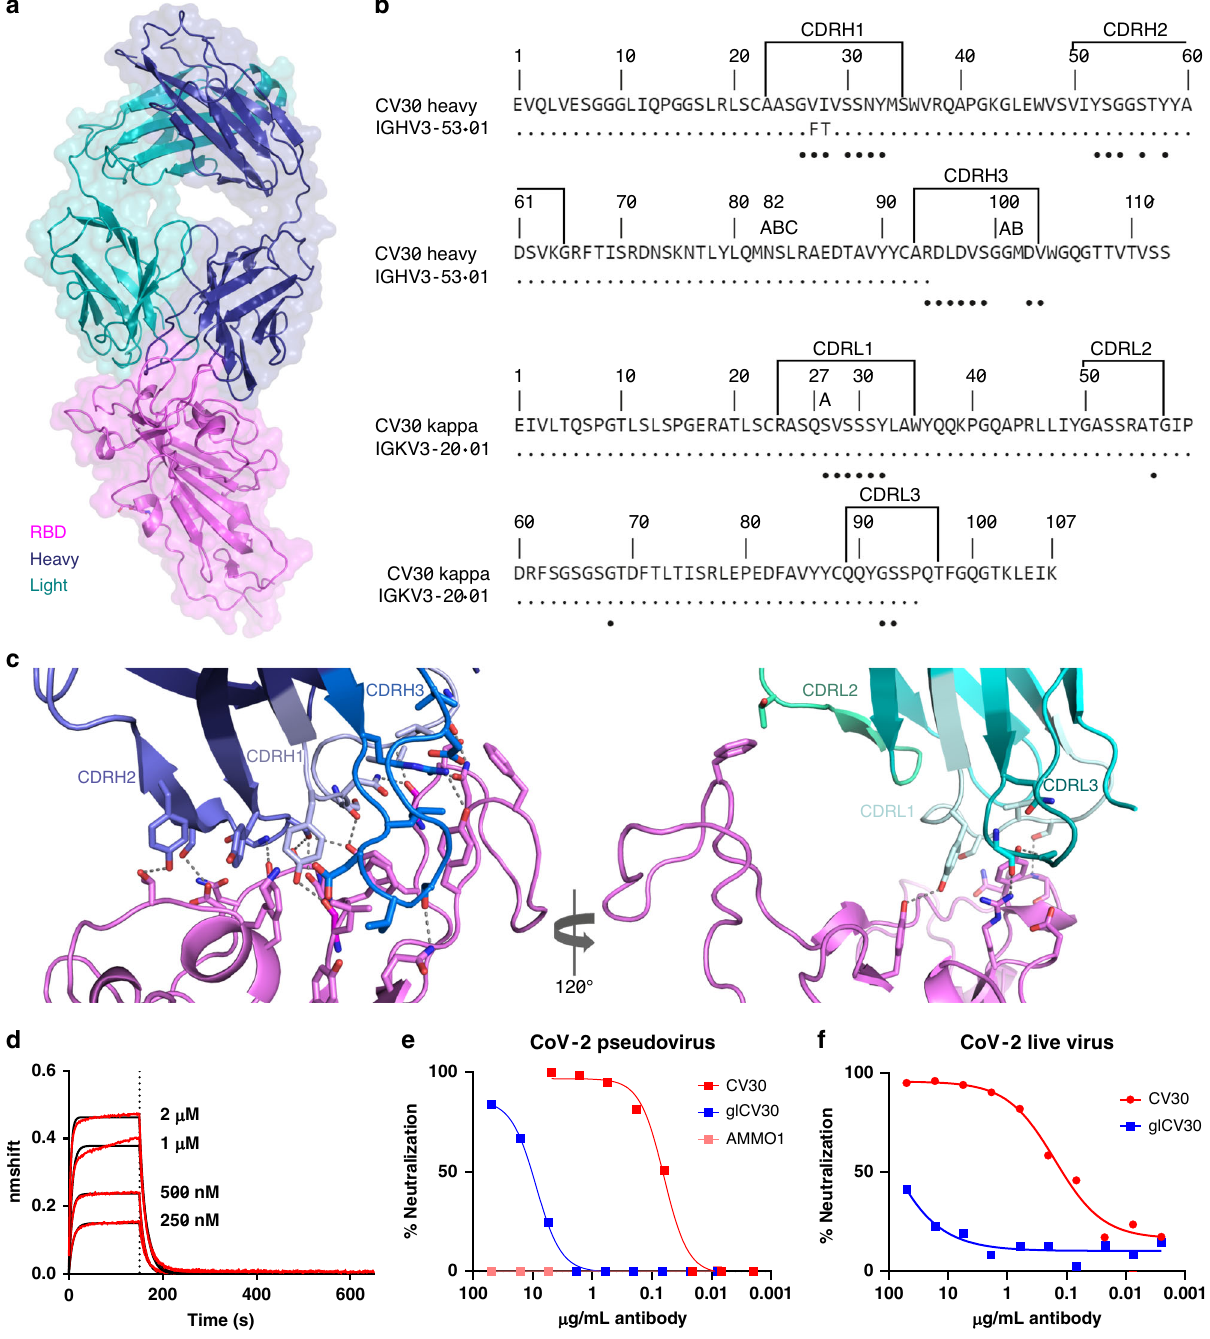
Fig. 1 Overall structure of CV30 Fab in complex with SARS-CoV-2 RBD and kinetics of glCV30. a Structure is shown in cartoon with surface representation shown in transparency. CV30 heavy chain is shown in dark blue and light chain in light blue. RBD is shown in pink. b Sequence alignment of CV30 heavy and light chains with germline genes. Black circles underneath the sequence indicate residues that interact with the RBD. c Details of the interactions of the heavy (left) and light (right) chains with the RBD. Complementary determining regions (CDRs) are labeled and colored as shown. Residues that interacts are shown as sticks and hydrogen bonds are shown in dotted lines. d Kinetics of glCV30 binding to RBD measured by BLI. Experimental data are shown in red with fi tted curve shown in black. Dashed line represents the transition from association to dissociation phase. e CV30 and glCV30 neutralization of SARS-CoV-2 pseudovirus. AMMO1 is an EBV-speci fi c antibody included as a control. f . CV30 and glCV30 neutralization of SARS-CoV-2 live virus. e , f Data points represent the mean of duplicates. Each experiment was repeated two times independently with similar results. d , e , f . Source data are provided as a Source Data fi similarity. CV30 and CB6 both have longer CDRH3 and bind Mapping the binding interactions of the RBD to each of the with higher buried surface area, ~263 and ~251 Å 2 , respectively, antibodies reveals a close overlap in the binding mechanism (Fig. 2d, e). The footprint of the heavy chain is nearly identical, as than B38 (~203 Å 2 ) (Fig. 2d and Supplementary Fig. 2). The large expected from the shared germline V-gene and sequence difference is in the light chain. CV30 has the smallest binding